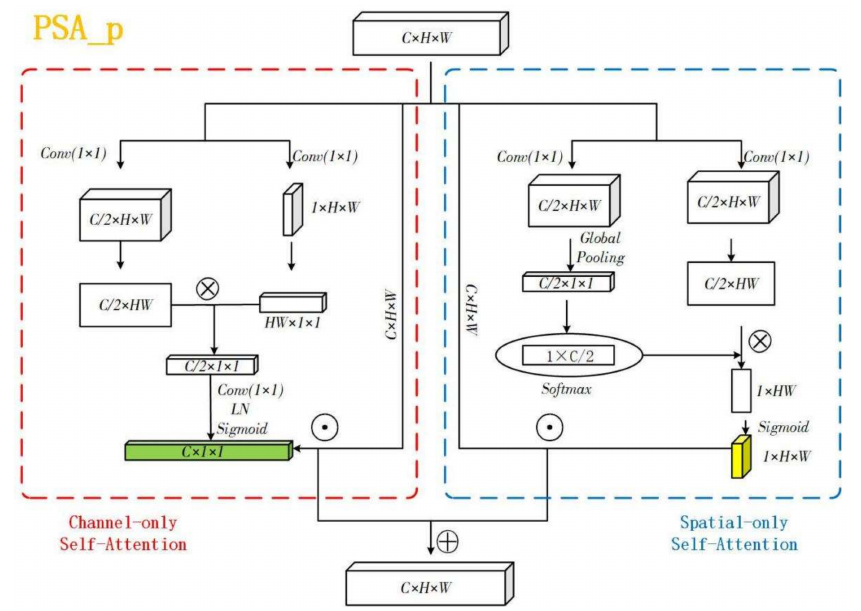
Figure 2. The attention mechanism PSA_p module. Channel-only Self-attention in the left half and Spatial-only Self-attention in the right half are parallelized and summed. LN is layer normalization. ⊗ is matrix multiplication.